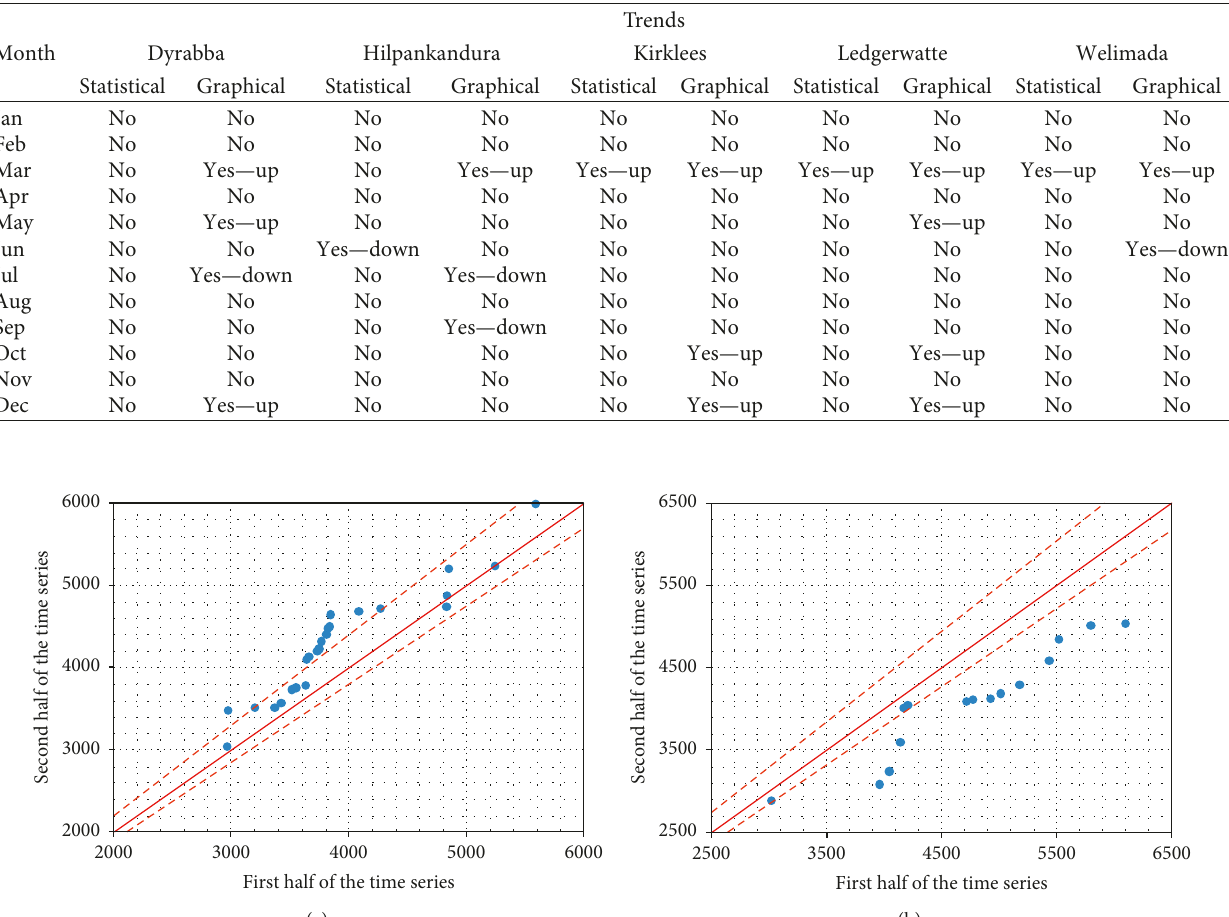
Table 4: Comparison results for monthly rainfalls for Uma Oya